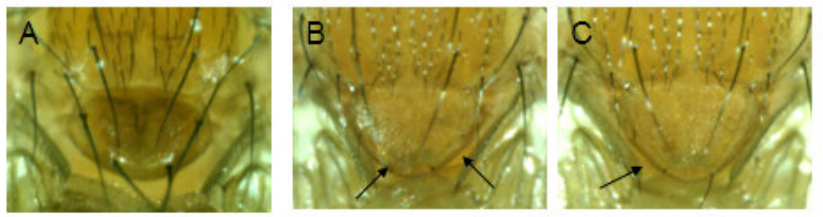
Figure 3. Phenotypes from RNAi flies. (A) W 1118 ; (B,C) UAS- Dnop5.IR /ptc-